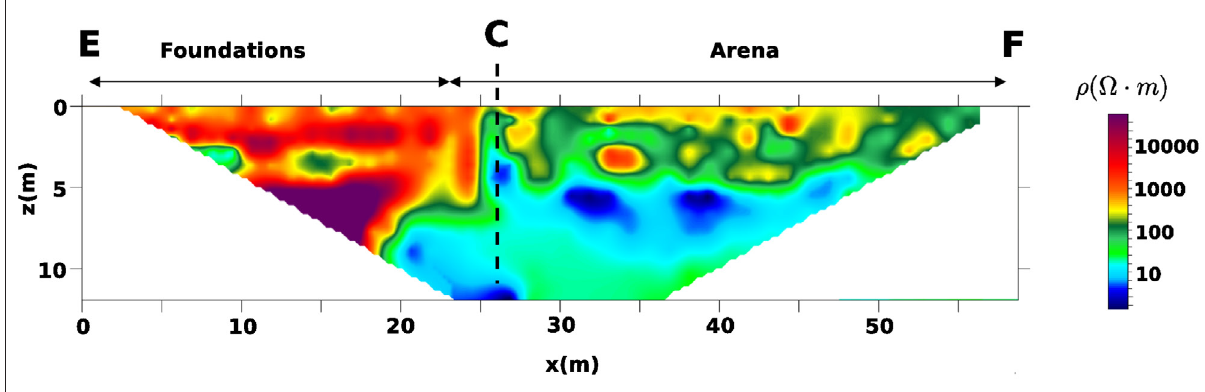
Figure 8. Results of the ERT line EF. The surface is at 16.05 m a.s.l., which is the elevation of the hypogeum . The dashed line indicates the projection of the starting point C of the C-D profile (Figures 6 and